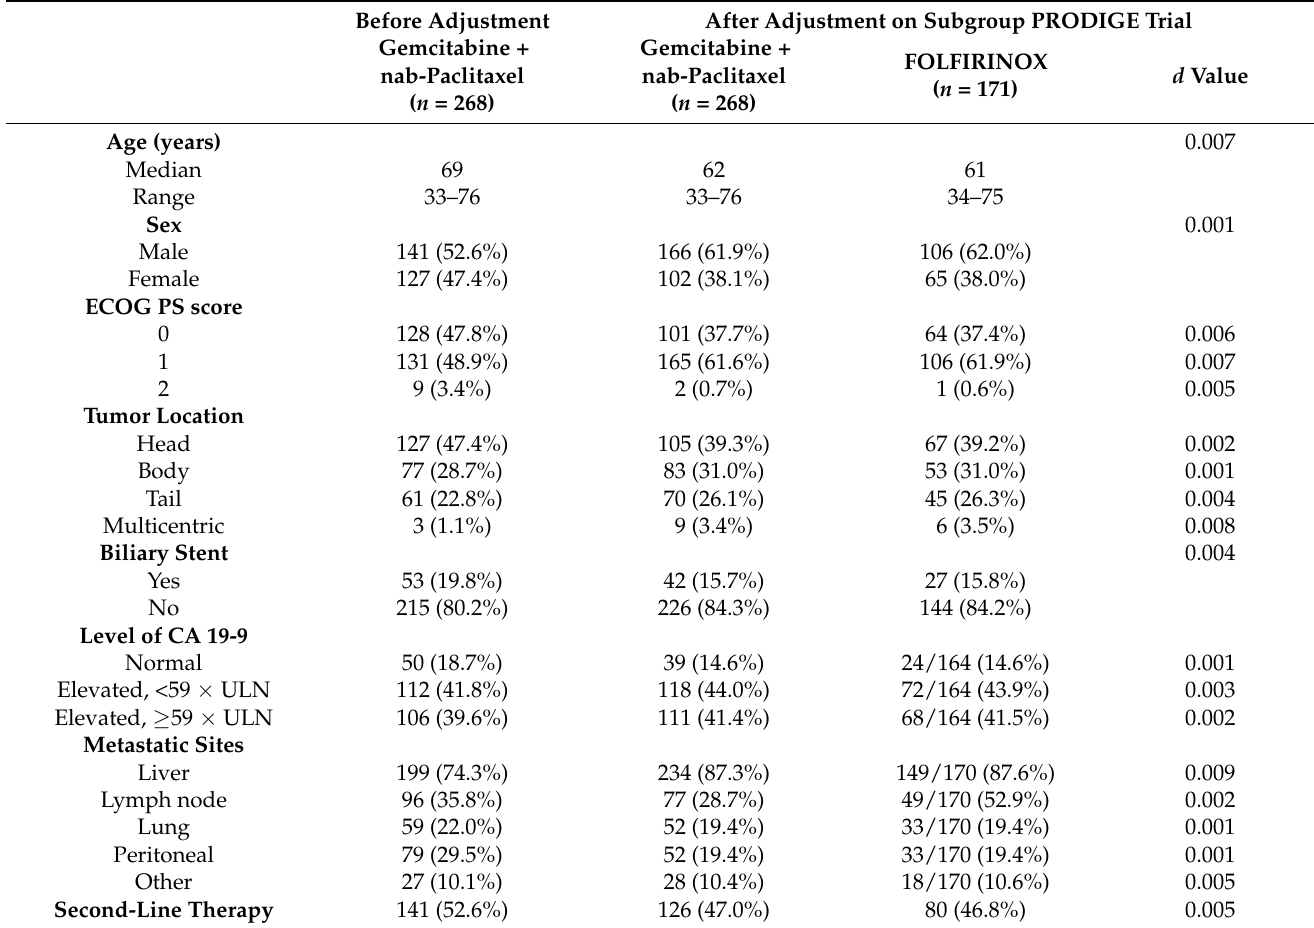
Table 1. Characteristics of patients receiving gemcitabine + nab-paclitaxel for metastatic pancreatic cancer before and after adjustment to balance the PRODIGE